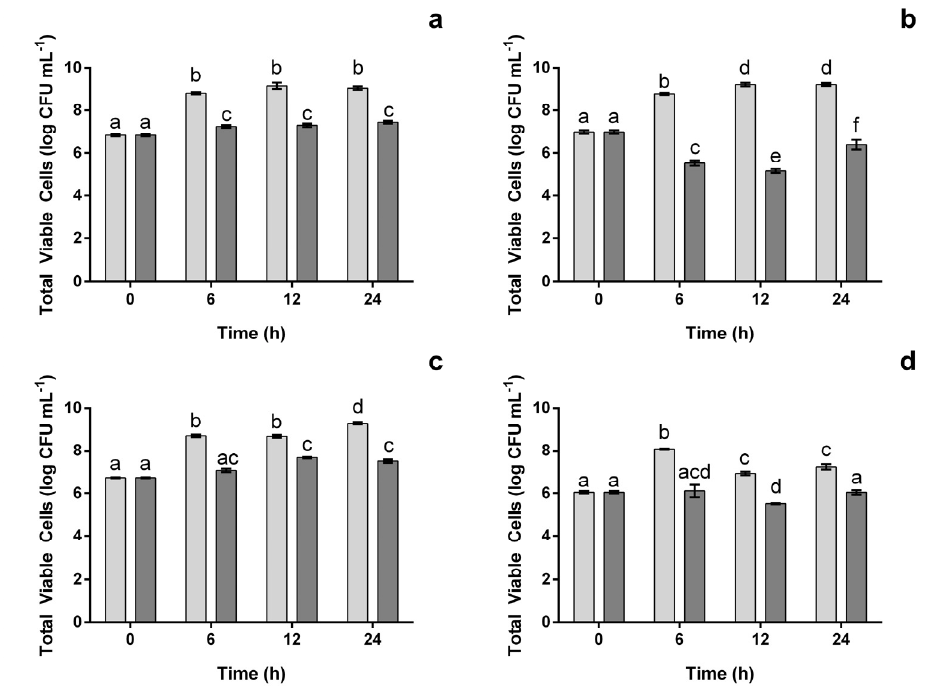
Figure 2. Total viable cells for L. monocytogenes ( a ), E. coli ( b ), S. enteritidis ( c ) and B. cereus ( d ) in the presence (( ■ ) 1000 µ g mL ) and absence ( ■ ) of the extract. The different letters represent the statistically significant ( p < 0.05) differences between each bar.